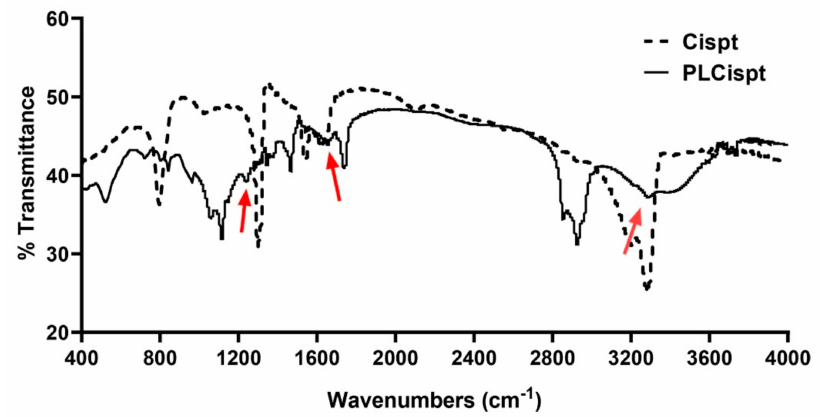
Figure 3. Fourier-transform infrared spectroscopy (FTIR) spectrum of the PLCispt. Arrows show the position of chemical bonds of Cispt which are preserved in